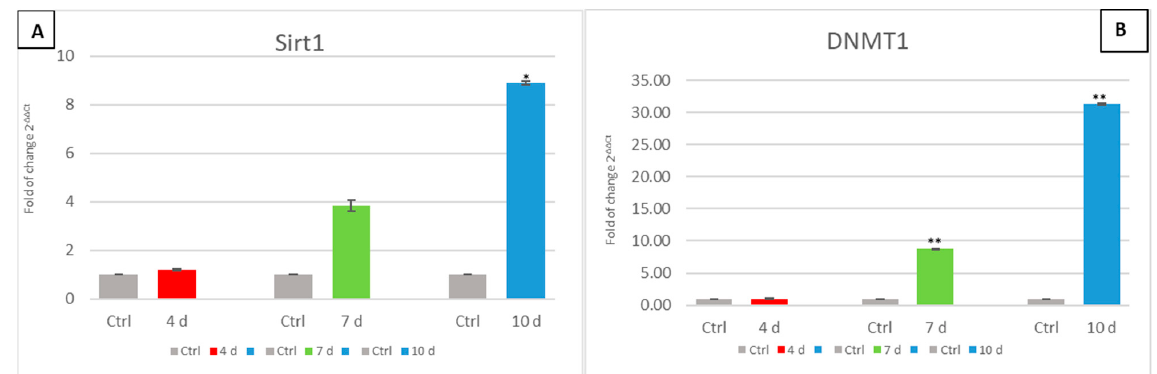
Figure 7. Expression of epigenetic modulating genes. The expression of SIRT1 (Panel ( A )) and DNMT1 (Panel ( B )) was evaluated in hADSCs cultured in the presence of 4d-MCF-7-EM (4d - red bars), 7d-MCF-7-EM (7d - green bars), or 10d- MCF-7-EM (10d - blue bars). The mRNA levels for each gene were normalized to Glyceraldehyde-3-Phosphate-Dehydro- genase (GAPDH) and expressed as fold of change (2 −ΔΔ Ct ) of the mRNA levels observed in untreated control hADSCs (Ctrl - grey bar) defined as 1 (mean ± SD; n = 6). Data are expressed as mean ± SD referred to the control (* p ≤ 0.05), (** p ≤ 0.01).